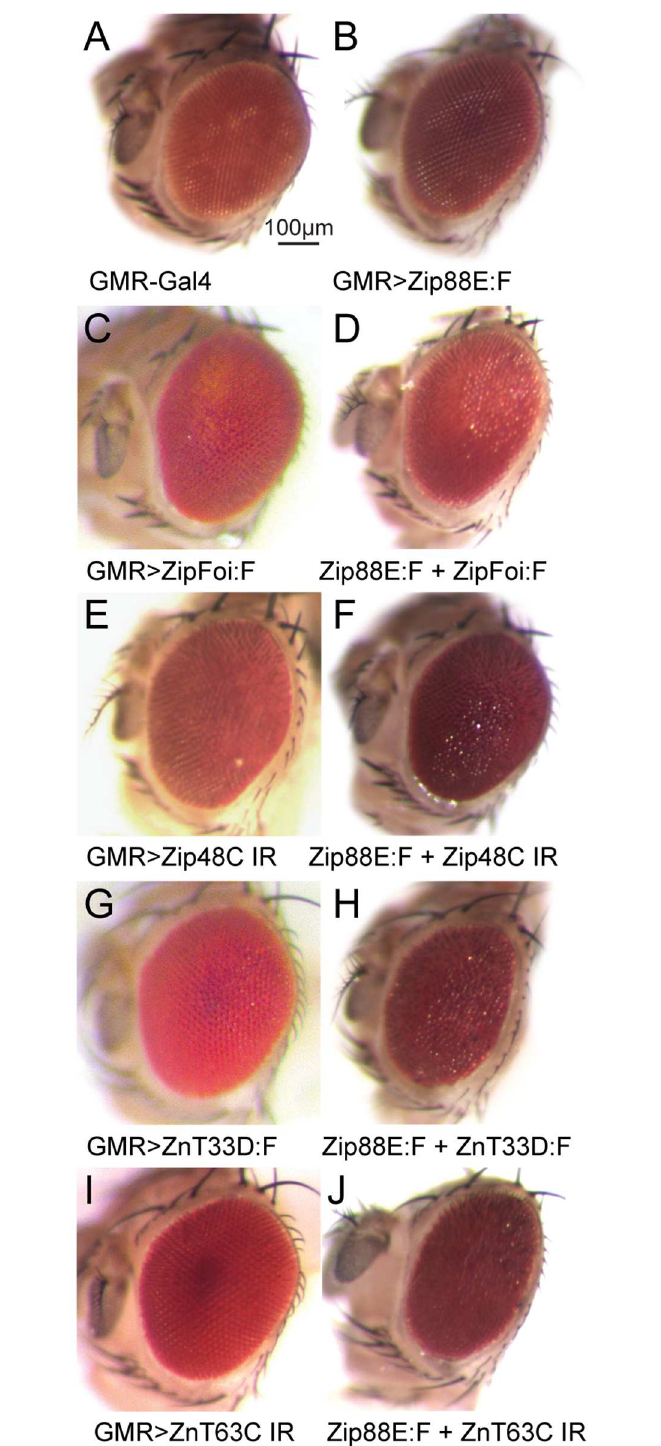
Fig 1. Zip88E over expression interacts with other zinc transport gene manipulations to disrupt eye development. GMR-GAL4 was used to drive ectopic Zip88E :: FLAG expressionin the developing Drosophila eye, alone and in combination with the over expressionand RNAi (IR) knockdownof various Zip and ZnT genes. A) GMR-GAL4- only control. B) GMR > Zip88E :: FLAG . C) GMR > ZipFoi :: FLAG . D) GMR > Zip88E :: FLAG + ZipFoi :: FLAG . E) GMR > Zip48C IR . F) GMR > Zip88E :: FLAG + Zip48C IR . G) GMR > ZnT33D :: FLAG . H) GMR > Zip88E :: FLAG + ZnT33D :: FLAG . I) GMR > ZnT63C IR . J) GMR > Zip88E :: FLAG + ZnT63C IR .